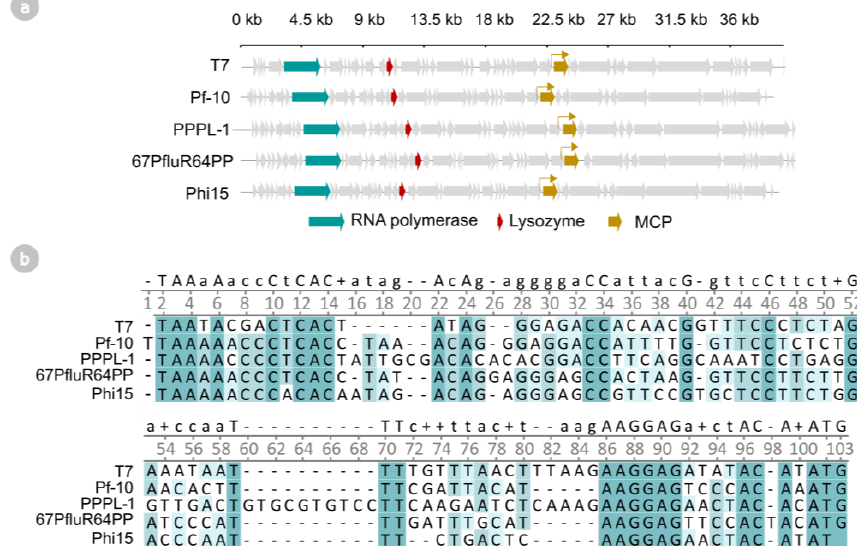
Figure 2. ( a ) Genomic organization of phages T7, Pf-10, PPPL-1, 67PfluR64PP, and phi15. The RNA polymerase genes, lysozyme genes, and major capsid protein (MCP) genes are indicated in teal, red, and yellow, respectively. ( b ) Multiple sequence alignment (ClustalOmega) of the predicted phage promoter and 5 (cid:48) untranslated region (UTR) of the phage’s major capsid protein. Darker shaded background colors indicate a higher level of